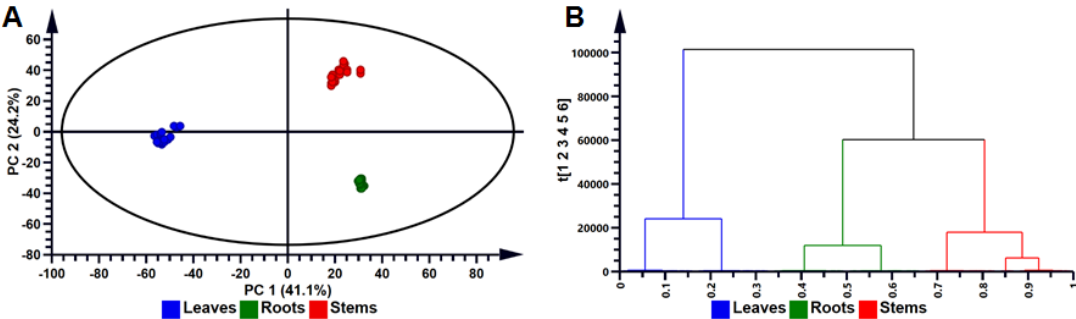
Figure 2. Multivariate data analysis of compositional di ff erences in hydromethanolic extracts of Bidens pilosa tissues types. ( A ) A PCA scores scatterplot of the Pareto -scaled data set obtained from LC-MS experiments. The six-component model (with PC 1 and PC 2 explaining 65.3% of the variation) indicate the general clustering within the datasets of B. pilosa tissues (leaves (blue), stems (red) and roots (green) samples). The quality parameters of the model are: explained variation / goodness-of-fit R 2 = 0.890 and the predictive variance Q 2 = 0.874. The ellipse in the PCA score scatterplot indicates the Hotelling’s T 2 at 95% confidence interval. ( B ) Hierarchical cluster analysis of the hierarchical structure of the data in dendrogram format. The model computed (using Euclidean distance and Ward’s minimum variance as a dissimilarity and linkage rule, respectively) shows tissue-specific clustering into two major groups, grouping roots and stems tissues together.